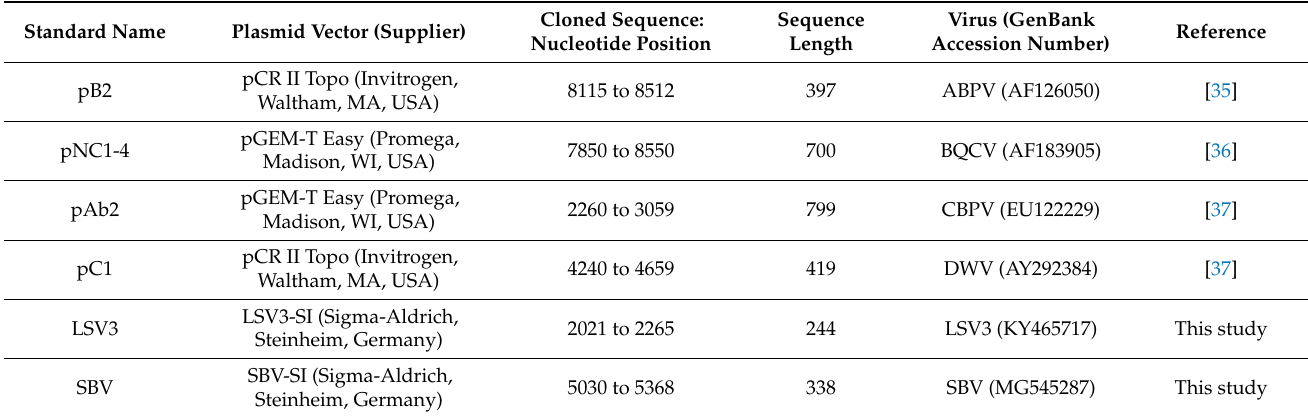
Table 2. Standards used for quantification of six honeybee viruses by RT-qPCR